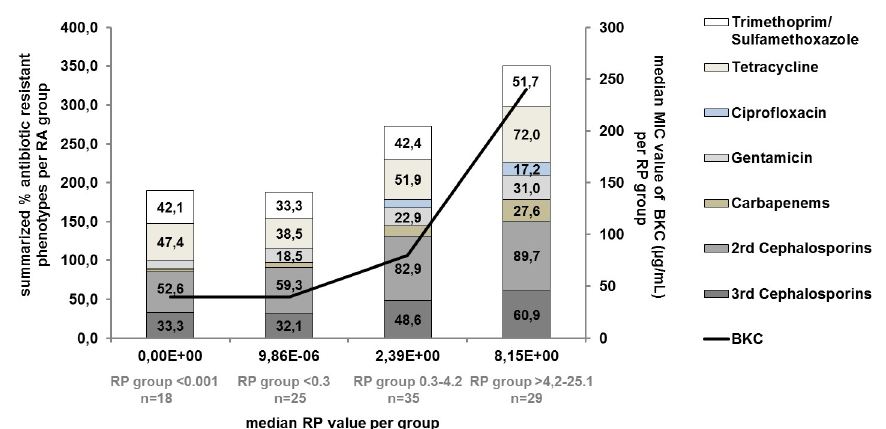
Fig 3. Correlation between median prevalence (RP) of intI1 and resistant phenotypes per RP group. The left Y-axis depicts the summarized % of antibiotic resistant phenotypes per RP group, the right Y-axis depicts the median MIC value of BKC ( μ g/mL) per RP group. The black line depicts the median of MIC values to benzalkonium chloride (BKC). Spearman correlation between median RP of intI1 and resistant phenotypes per RP group was found at 0.95. Numbers in stacked bars are % of resistant phenotypes to the respective antibiotic. Please see method section for RP groups.